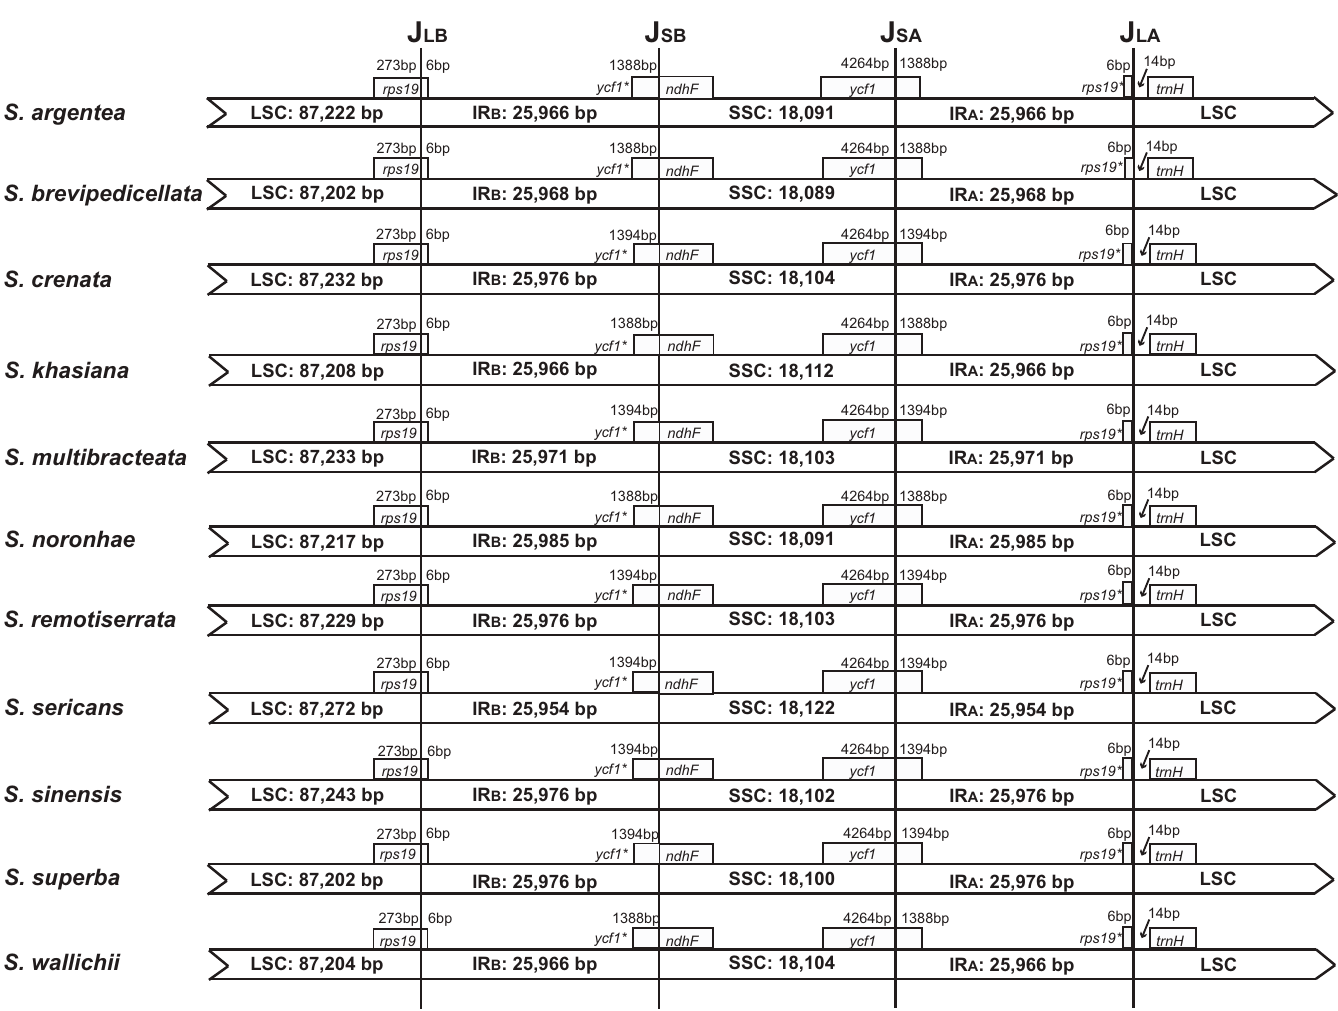
proposed “most promising chloroplast DNA barcode” of land plants [39], was only 0.67%. Among the 79 noncoding ( > 150 bp) regions, the percentage of variation ranged from 0.11% to 2.85% (Fig 4 and Table 3). Fourteen fragments ( atpI-rps2 , trnS ( UGA ) -psbZ , rps4-trnT ( UGU ), trnL ( UAA ) -trnF ( GAA ), petB-petD , rpl2 intron, rpl23-trnI ( CAU ), ycf15-trnL ( CAA ), trnL ( CAA ) -ndhB , ndhB intron, trnV ( GAC ) -rrn16 , rrn16-trnI ( GAU ), trnA ( UGC ) intron, trnN ( GUU ) -ndhF ) did not show any sequence variation. Eight potential mutational hotspots ( trnW ( CCA ) -trnP ( UGG ), trnT ( UGU ) -trnL ( UAA ), trnG ( UCC ) -trnfM ( CAU ), petD-rpoA , psbB- psbT , ndhE-ndhG , ndhC-trnV ( UAC ), rpl32-trnL ( UAG )) were identified, with the variation percentage exceeding 2.0% among the 11 sampled species (Fig 4 and Table 3). These eight highly variable hotspots may have the potential to be used as special DNA barcodes for identi- fying Schima species.